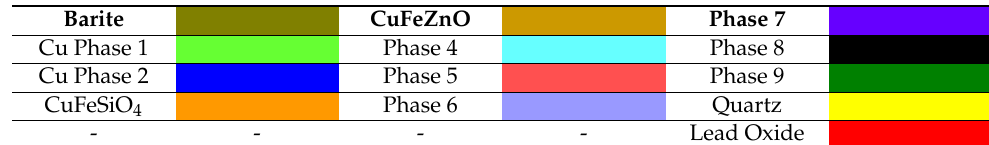
Figure 6. AMICS image of FF-ESP dust. Table 3. AMICS color